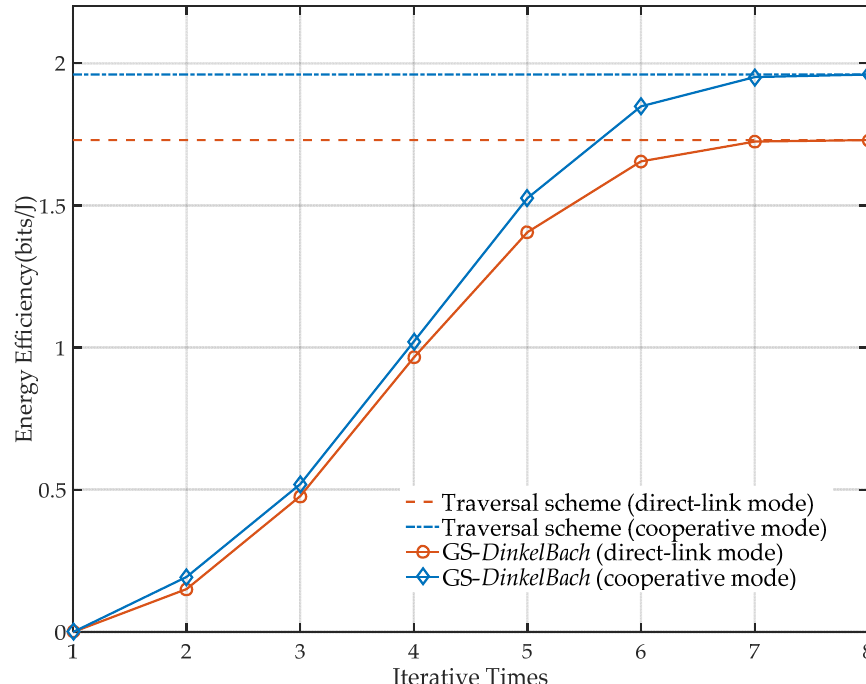
Figure 8. Network EE curves in different modes ( 𝑎 = 0.2 ).